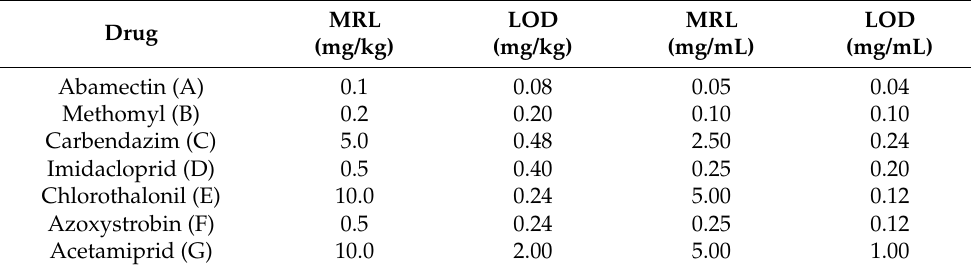
Table 2. The comparison between MRL and LOD of the seven pesticide residues in